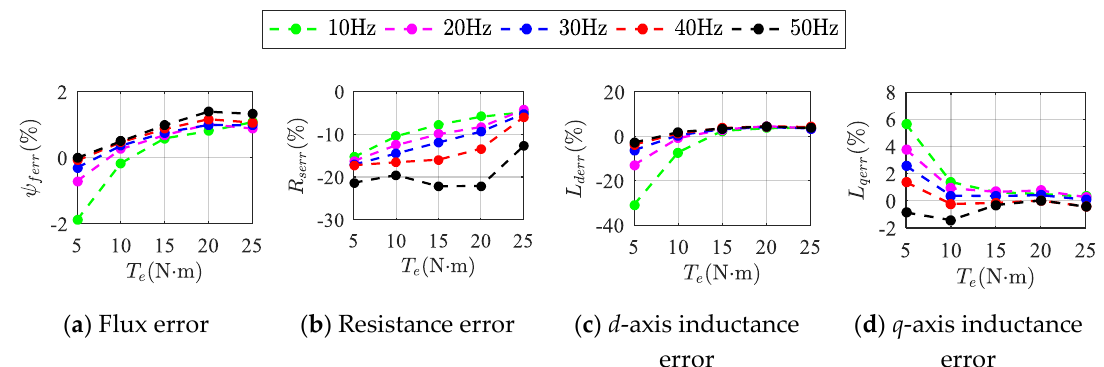
( d ) dq -axis voltages Figure 8. Currents and voltages of the parameter identification method. 4.3. Experimental Results for Different Speeds Figure 9 shows the experimental results for different speeds using left shift mode. The magnitude of R s 1 err increased with increasing speed. One reason has already been mentioned above. The identification equation of R s can be approximated as △ u d / △ i d , which is not related to speed. However, the voltage errors, which were caused by nonideal factors and related to speed, resulted in increasing R